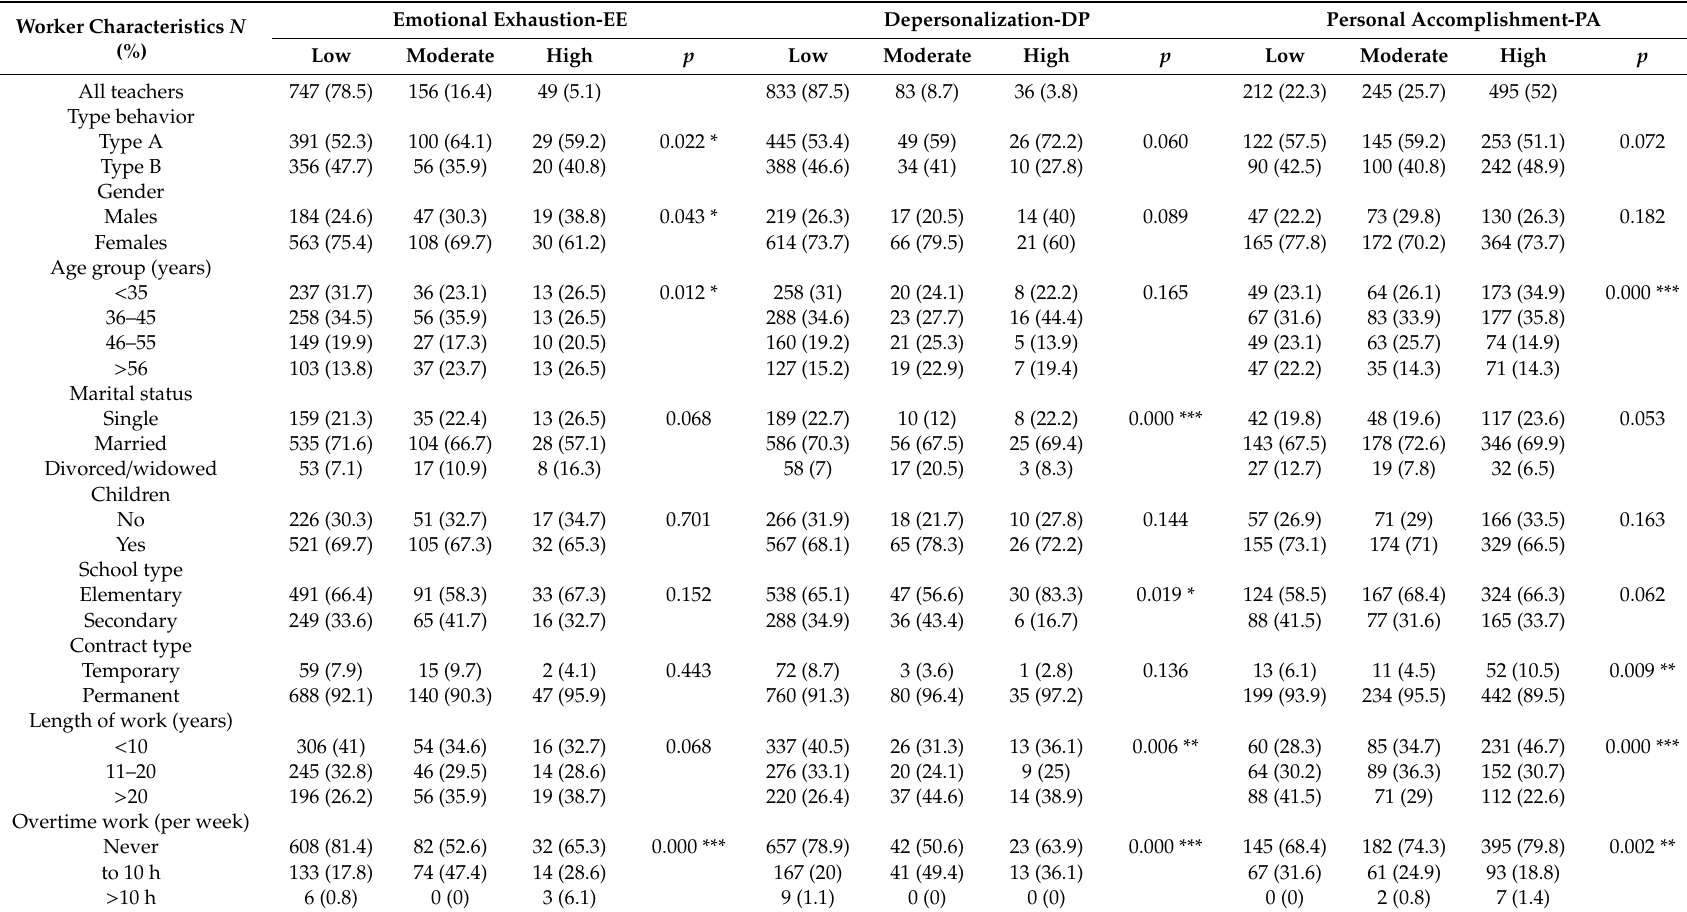
Table 4. Scores on burnout syndrome scales stratified by individual and socio-demographic characteristics Worker Characteristics N